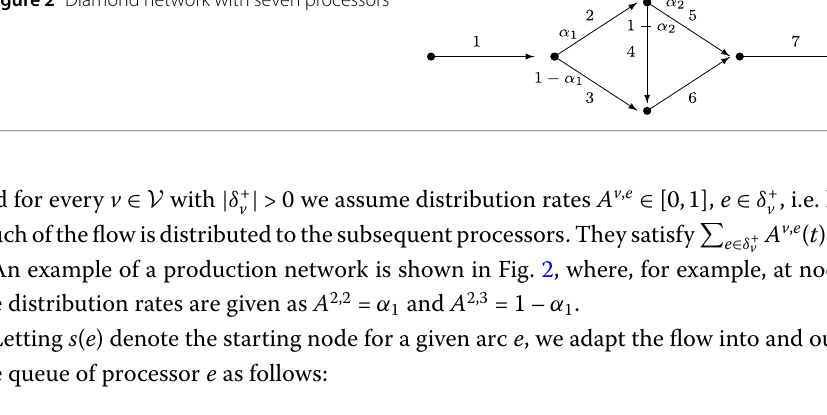
Figure 2 Diamond network with seven